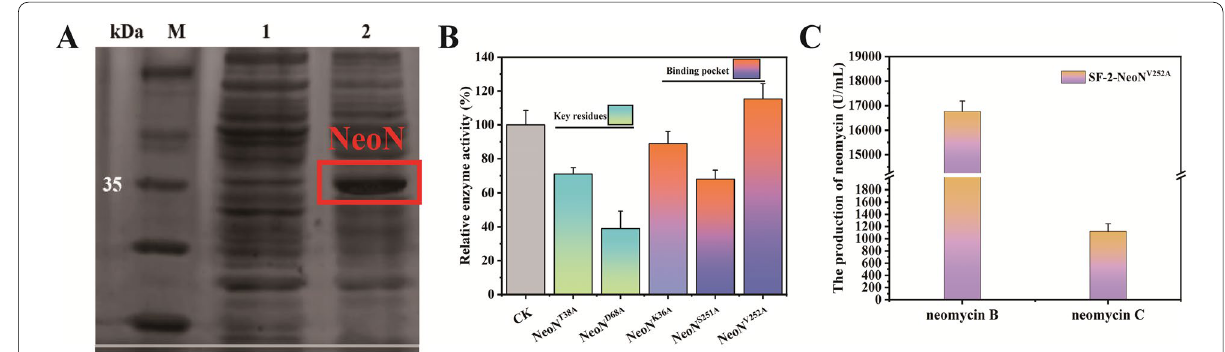
Fig. 5 Effects of NeoN mutant on neomycin production. A Expression of NeoN in E . coli BL21. B Relative enzyme activities in NeoN mutants. C Production of neomycin B and neomycin C by strain SF-2-NeoN V252A during